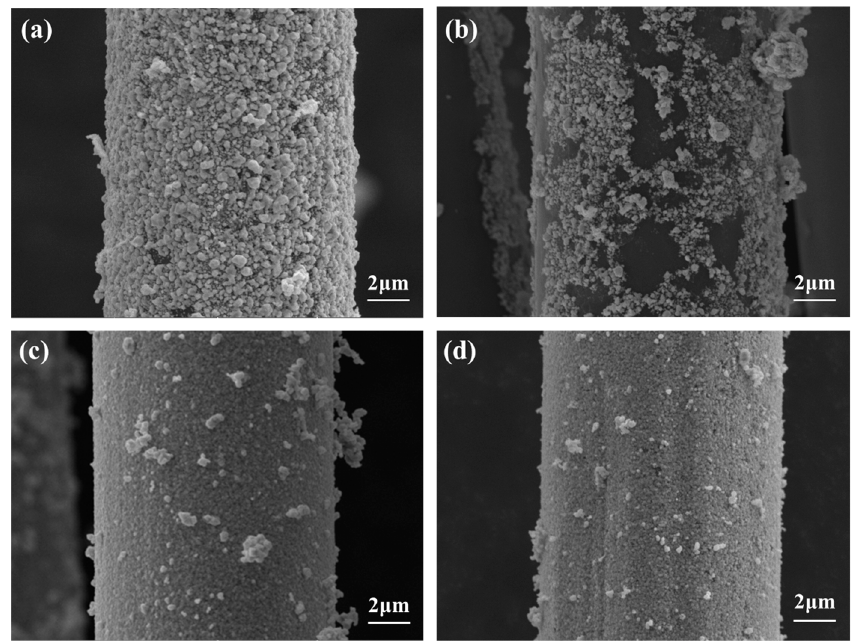
Figure 7. The SEM images of pristine PPTA-PDA/Ag fibers before ( a ) and after ( b ) 10 washing cycles, plasma-treated PPA-PDA/Ag fibers before ( c ) and after ( d ) 10 washing cycles. The AgNO 3 concentration was 20 g/L.